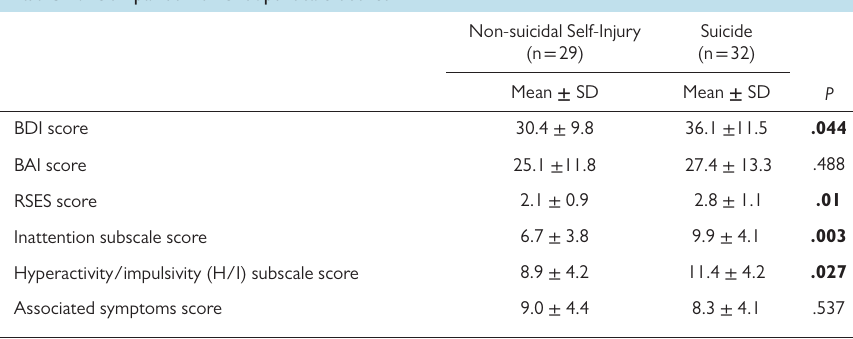
Table 2. Comparison of Groups’ Scale Scores